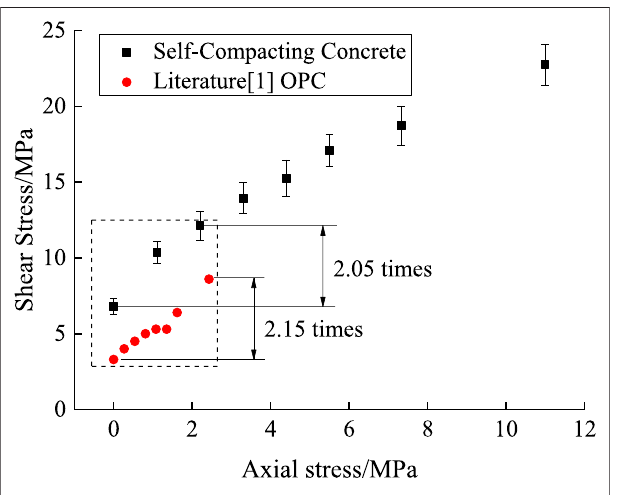
FIGURE 13 | The principal tensile stress and lateral compressive stress of SCC.